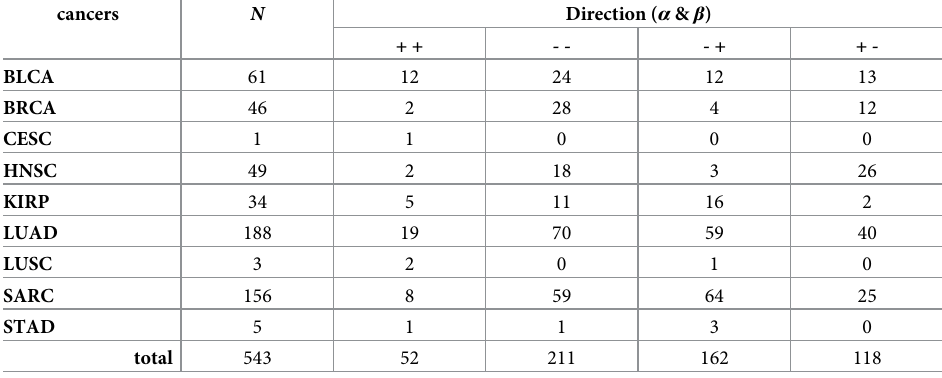
Table 4. Direction of the effect of methylations on expression and the effect of expression on the survival risk of cancers for identified genes with mediating influence. cancers